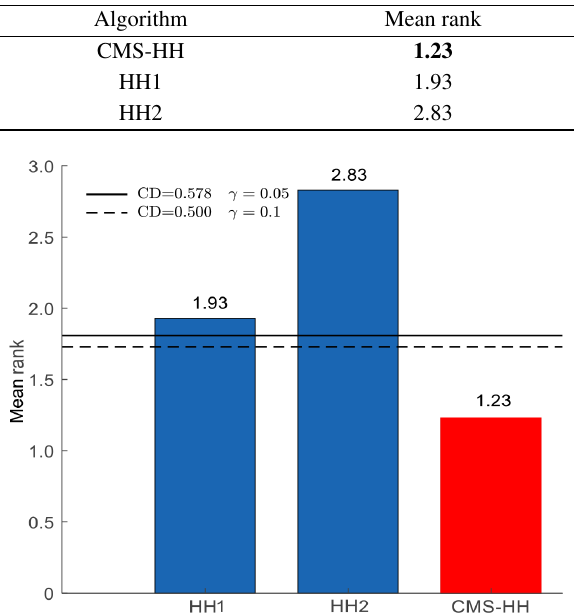
Table 10 Friedman-test results of CMS-HH, HH1, and HH2.